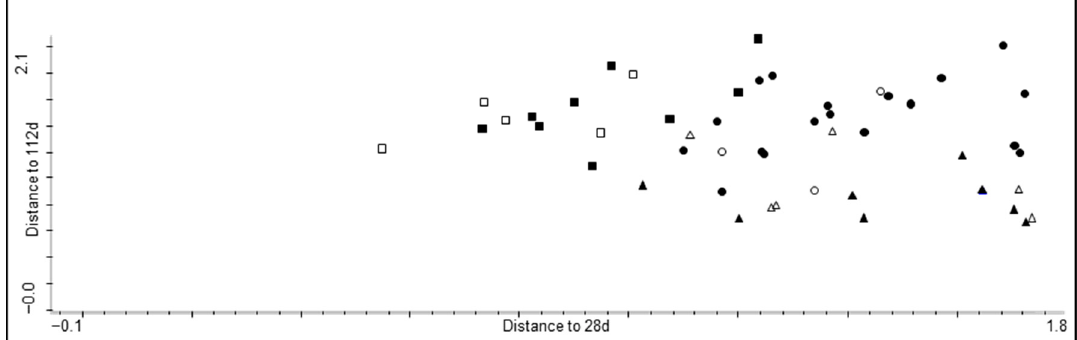
Figure 3. Scatter plot of the distances between lyophilized cheese water-soluble extracts of two different classes, according to days of ripening; 28 d, 28 days; 112 d, 112 days;